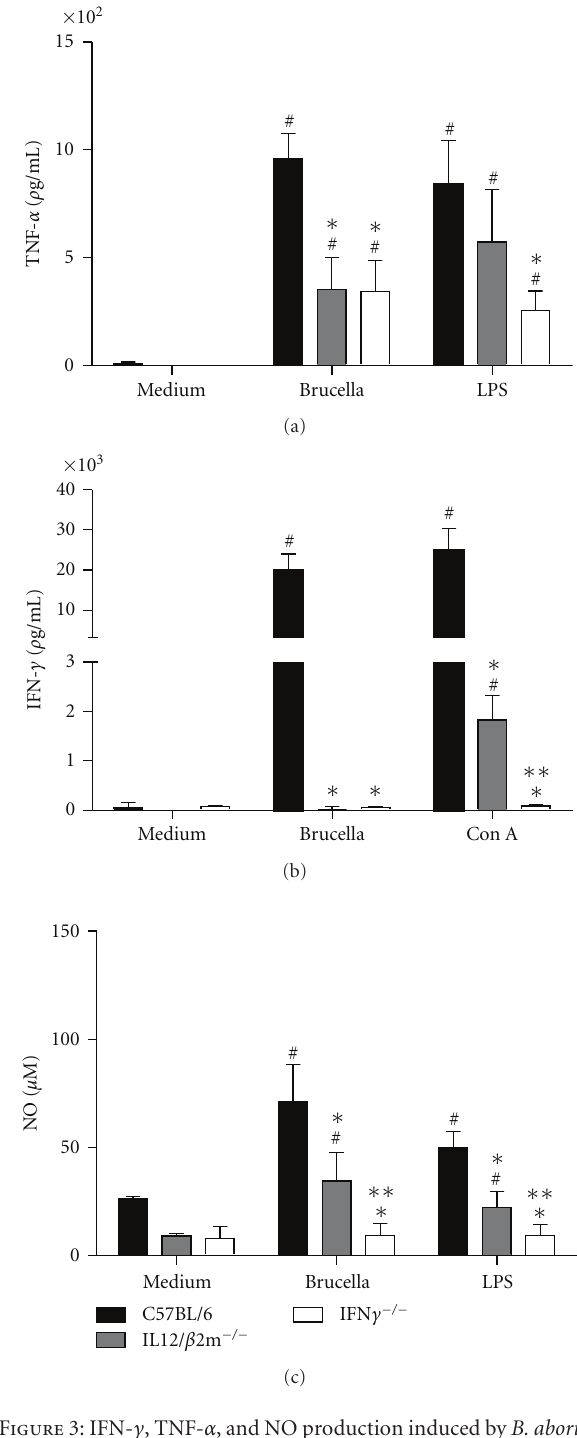
Figure 3: IFN- γ , TNF- α , and NO production induced by B. abortus in IFN- γ KO or IL-12/ β 2-m KO splenocytes. Spleens cells (1 × 10 6 cells) were stimulated with B. abortus S2308 (MOI 100 :1), Con A (5 μ g/mL), or E . coli LPS (1 μ g/mL). Levels of TNF- α (a) and IFN- γ (b) were measured by ELISA after 48 and 72hrs, respectively. Levels of NO 2 − (c) were measured by Griess reaction after 48 hrs of antigen stimulation. Statistically significant di ff erences in relation to C57BL/6 mice are indicated by an asterisk ( P < 0 . 05), in relation to IL-12/ β 2-m − / − by two asterisks, and those between unstimulated and stimulated spleen cells are indicated by the symbol # ( P < 0 .